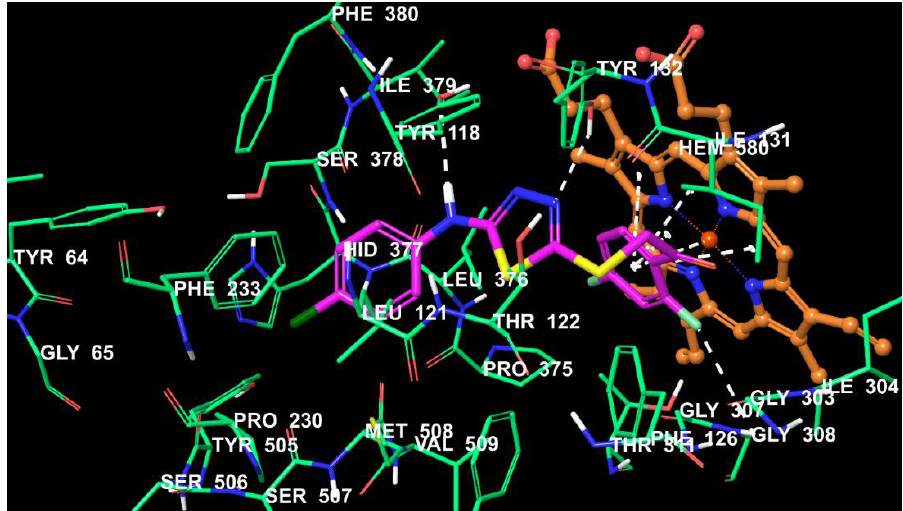
Figure 5. The interacting mode of compound 3k in the active region of 14- α -sterol demethylase (PDB code: 5FSA). The inhibitor is colored purple, and the heme molecule is colored orange.